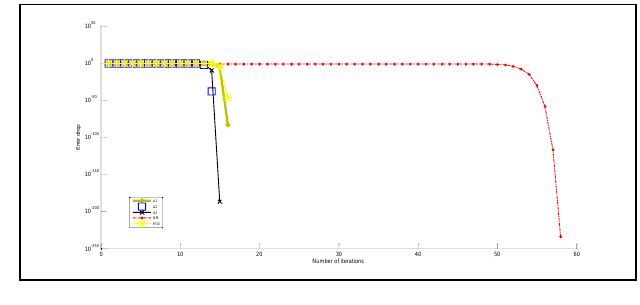
Fig. 6. Error drops for example 3